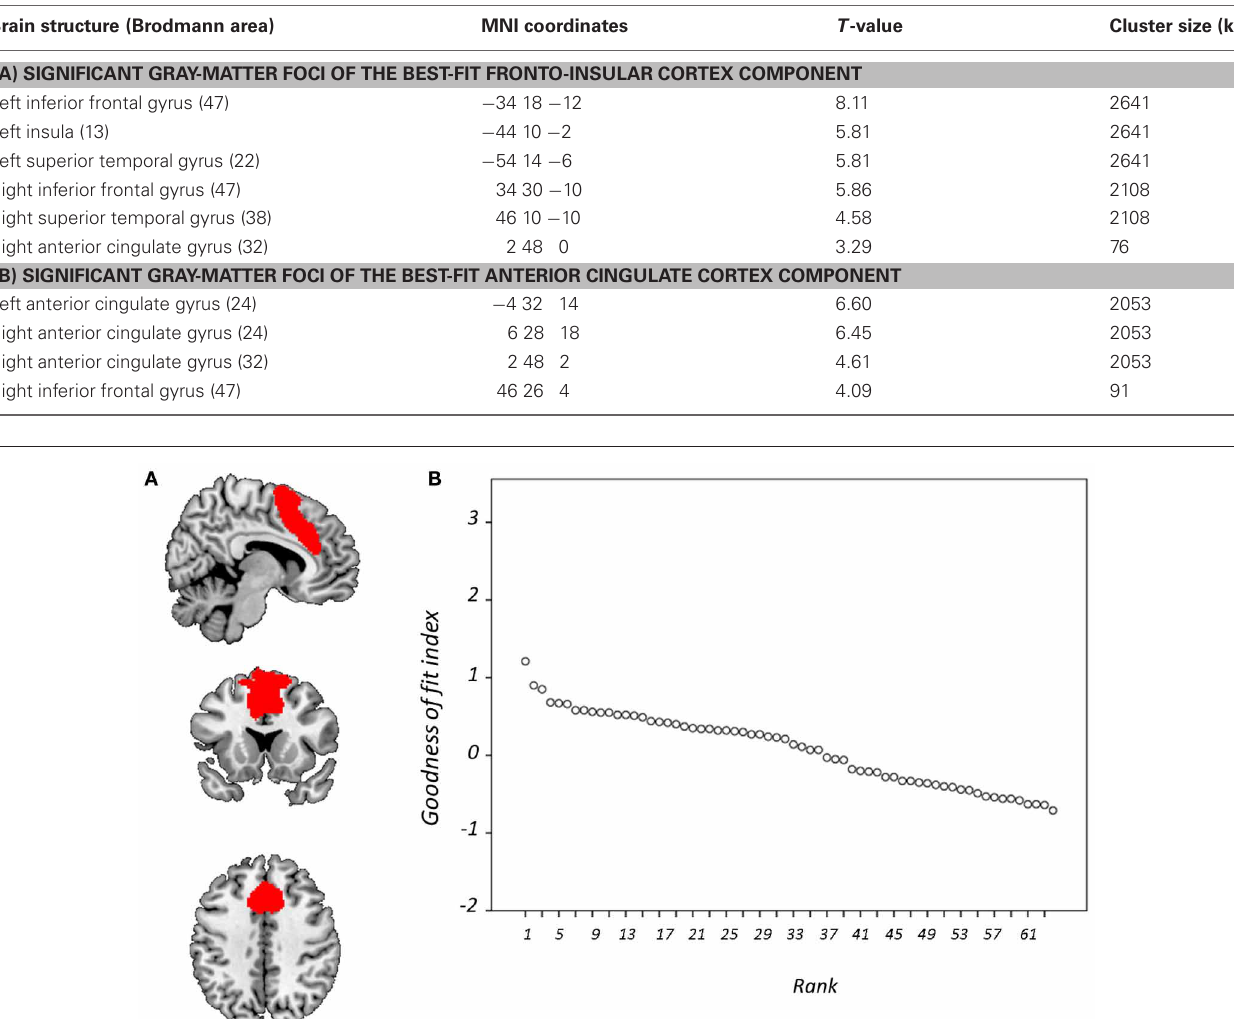
Table 4 | One-sample T -test results for the best-fit salience network components.